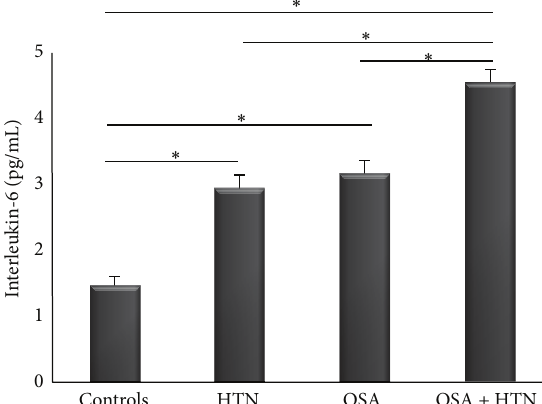
Figure 1: Carotid IMT in controls, HTN, OSA, and OSA + HTN subjects. ∗ 𝑝 < 0.01 ; ∗∗ 𝑝 < 0.05 .